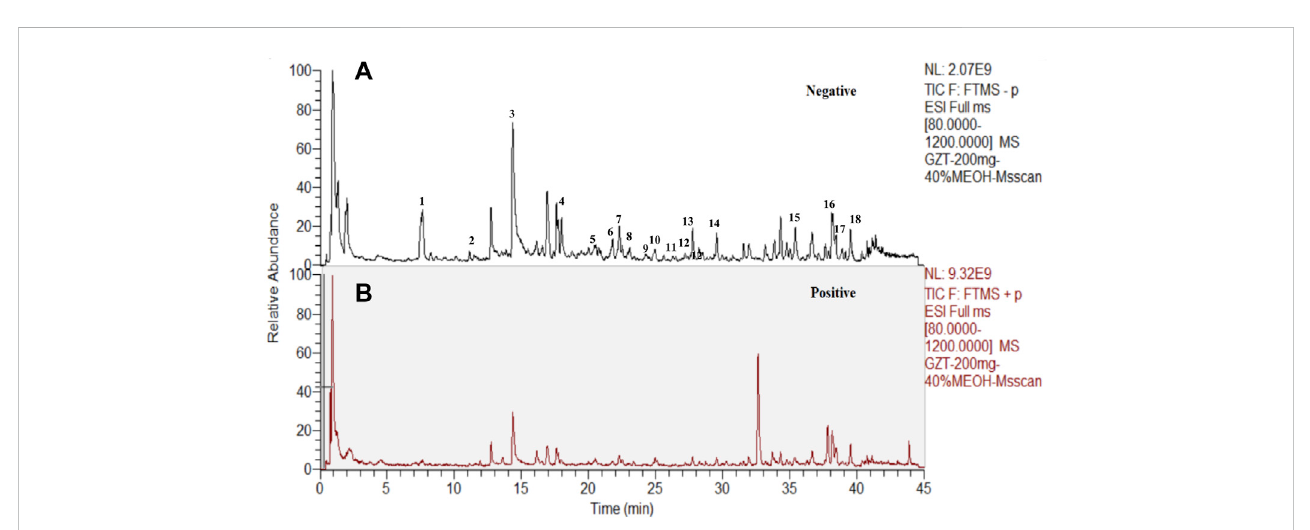
FIGURE 1 Eighteen compounds of GZD by UPLC [ (A) negative, (B) positive ion mode]: 1. (+)-catechin, 2. paeoni fl origenone, 3. paeoni fl orin, 4. pratensein, 5. lacti fl orin, 6. liquiritigenin, 7. glycyroside, 8. licochalcone B, 9. quercetin, 10. licorice glycoside E, 11. echinatin, 12. kaempferol, 13. benzoylpaeoni fl orin, 14. formononetin, 15. licoiso fl avone A, 16. licochalcone A, 17. licoiso fl avone B, and 18.